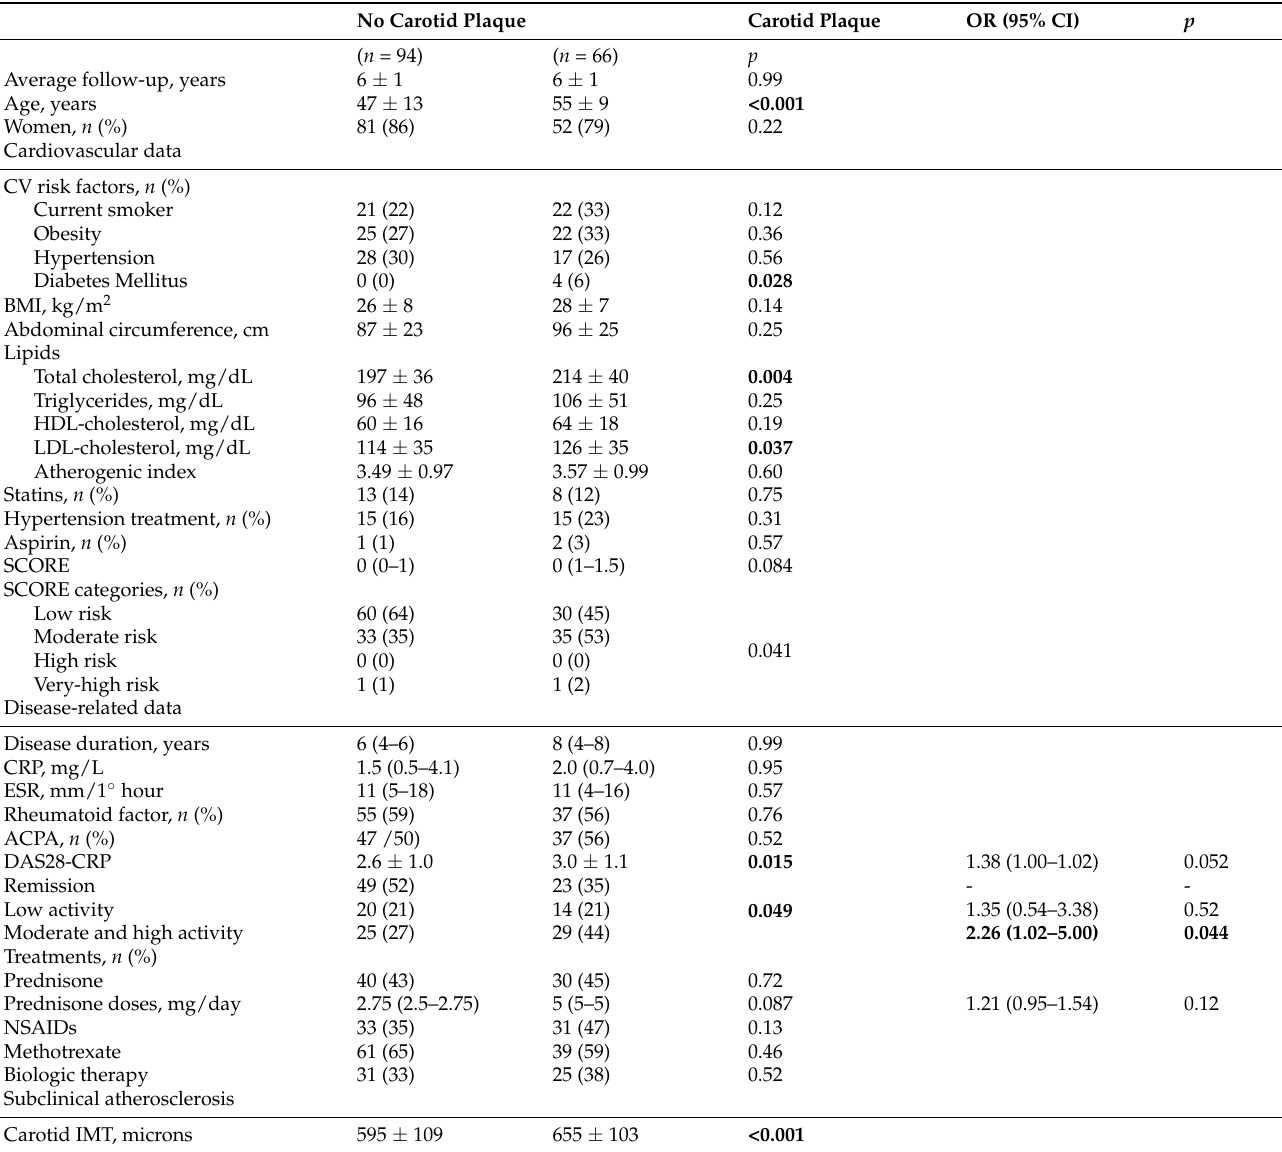
plaque at the end of the study. The average time of follow-up was 6 ± 1 years in both groups. Patients who developed carotid plaque were significantly older (55 ± 9 vs. 47 ± 13 years, p < 0.001) at baseline; were more frequently diabetic (6% vs. 0%, p = 0.028); and had (126 ± 35 vs. 114 ± 35 mg/dL, p = 0.037) at the beginning of the study. As expected, patients who developed carotid plaque at the end of the follow-up had a higher cIMT